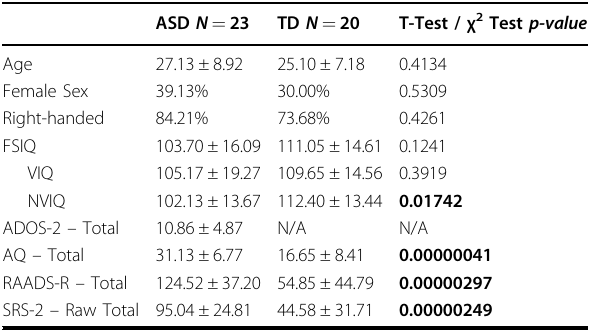
Table 1 HFASD participant demographics and clinical